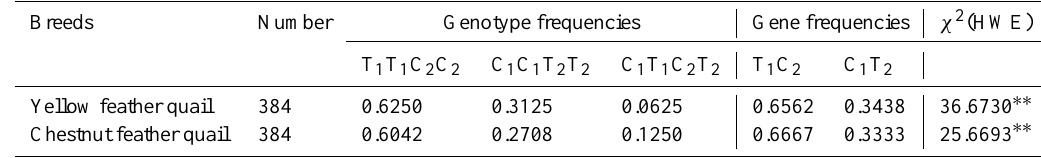
Table 2. Allele and genotype frequencies at intron 11 locus of VLDLR gene in two quail populations. Breeds